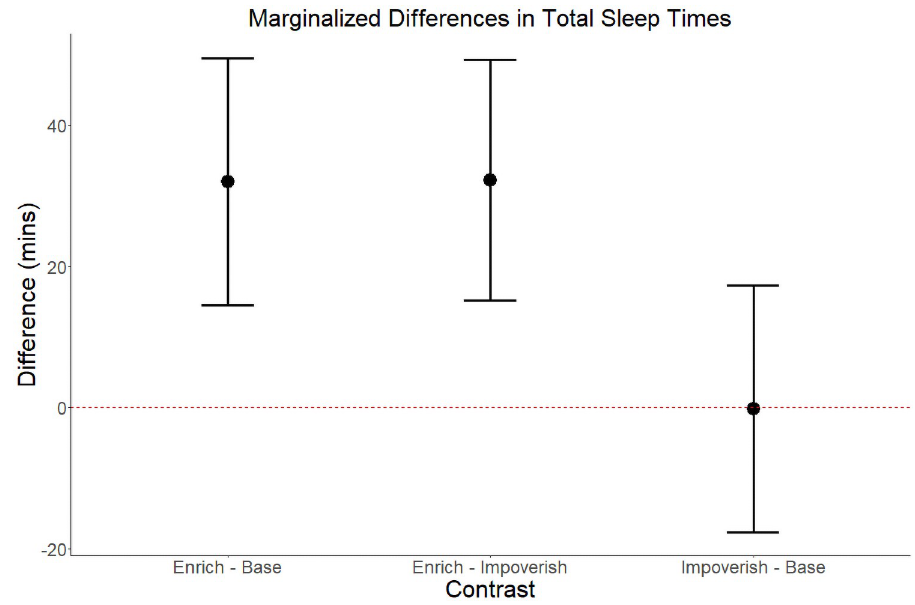
Fig 3. Estimated effects of experimental condition on total sleep time. The estimated differences in total sleep time (in minutes and marginalized over the estimated effects of condition order) for each pair of experimental conditions. Error bars represent two standard errors of the estimated population mean difference for the given contrast.